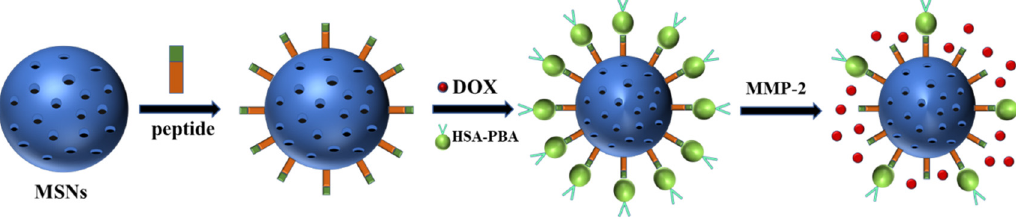
Figure 6. Design consideration of enzyme-responsive MSNs. Abbreviations: DOX, doxorubicin; HAS, human serum albumin; PBA, phenylboronic acid; MMP-2, matrix metalloproteinase-2. Table 10. Various responsive MSNs are used to deliver cargos.